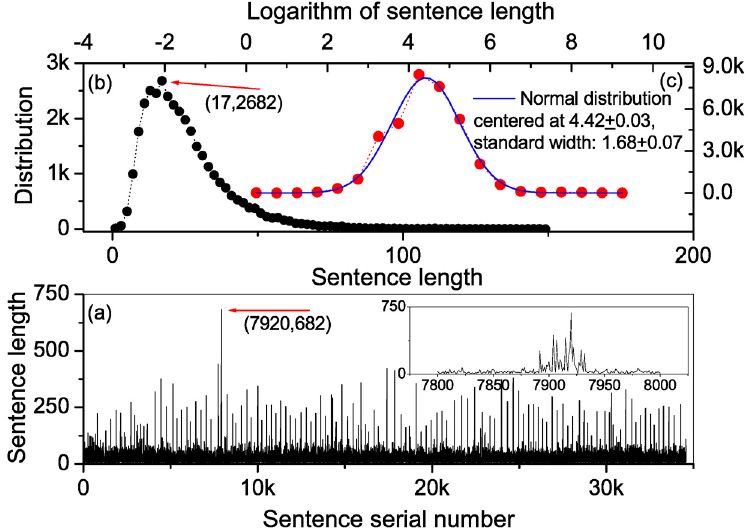
Fig 1. Statistics of sentence lengths. (a) Sentence length series. Inset : some sentences with large lengths are clustered together. This cluster is due to the traditional Chinese full stop symbol (small open circle) that was used in the 30th chapter, which produced noisy data. (b) Sentence length follows a right-skewed distribution, which is the log-normal distribution in